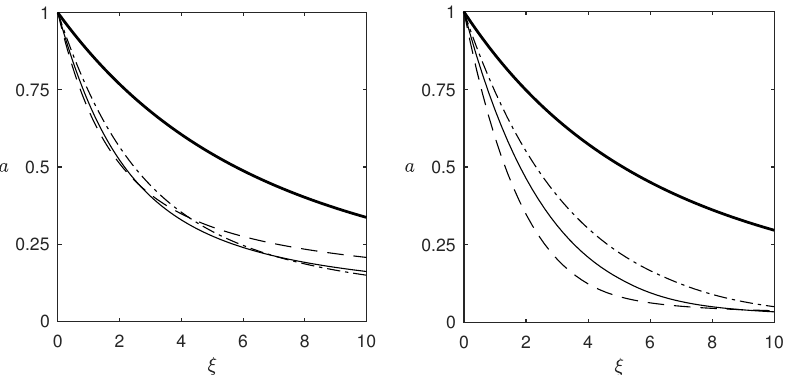
Figure 4. Damping of a solitary wave under various values of Wi: dimensionless wave height, a , as a function of dimensionless time, ξ . Bold lines: Wi → ∞ (Newtonian fluid); dashed-dotted line: Wi = 2; solid lines: Wi = 1; dashed lines: Wi = 0.5. Left: d = 2. Right: d =